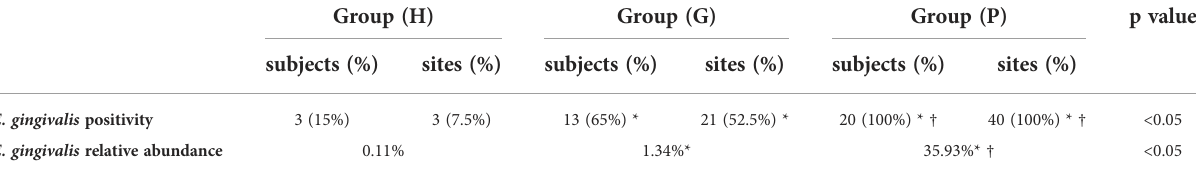
TABLE 2 Comparison of the prevalence and relative abundance of Entamoeba gingivalis ( E. gingivalis ) at the genus level in patients with different periodontal